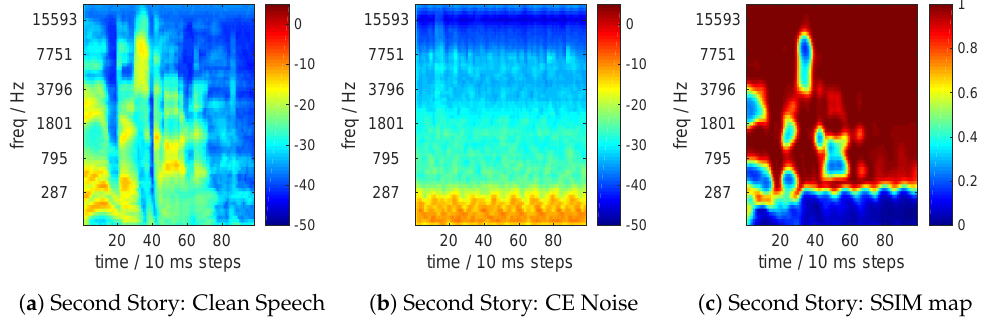
Figure 6. ( a ) The gammatonegram of one of the words uttered (and presented to the subjects in the experiments for the word spotting task) from the second story without any masker; ( b ) the gammatonegram of the masker (car engine noise) sound frame overlapping the word in ( a ); and ( c ) the SSIM map between the two gammatonegrams in ( a , b ). The SSIM index is 0.78.